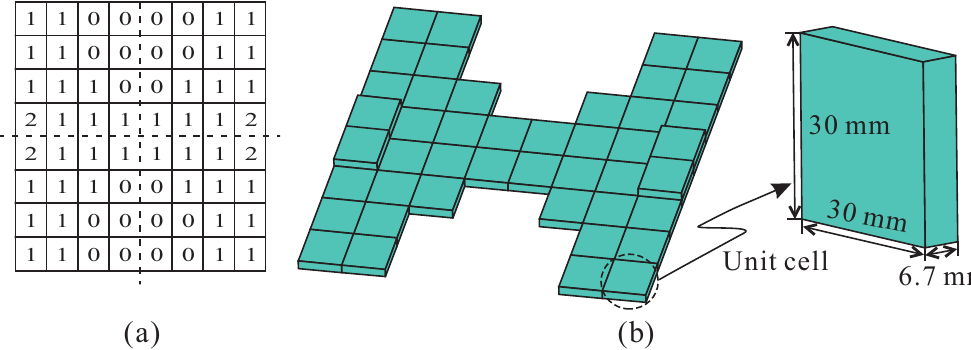
Figure 4. Ferrite configuration: ( a ) Optimized 8 × 8 grid cells; ( b ) Optimized ferrite configuration and unit